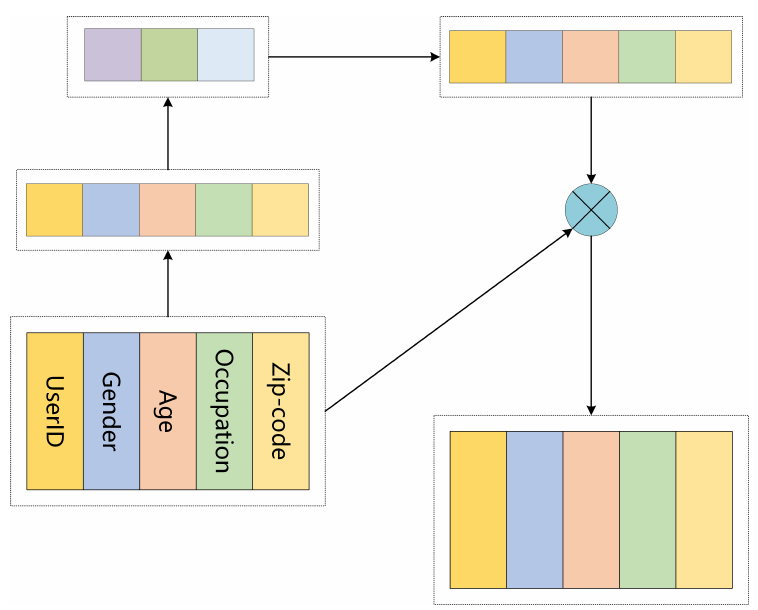
Figure 4. User network attention calculation schematic. The user features are first obtained as attention scores, and then the attention scores are element-wise product with the user features to obtain the vector of user features with